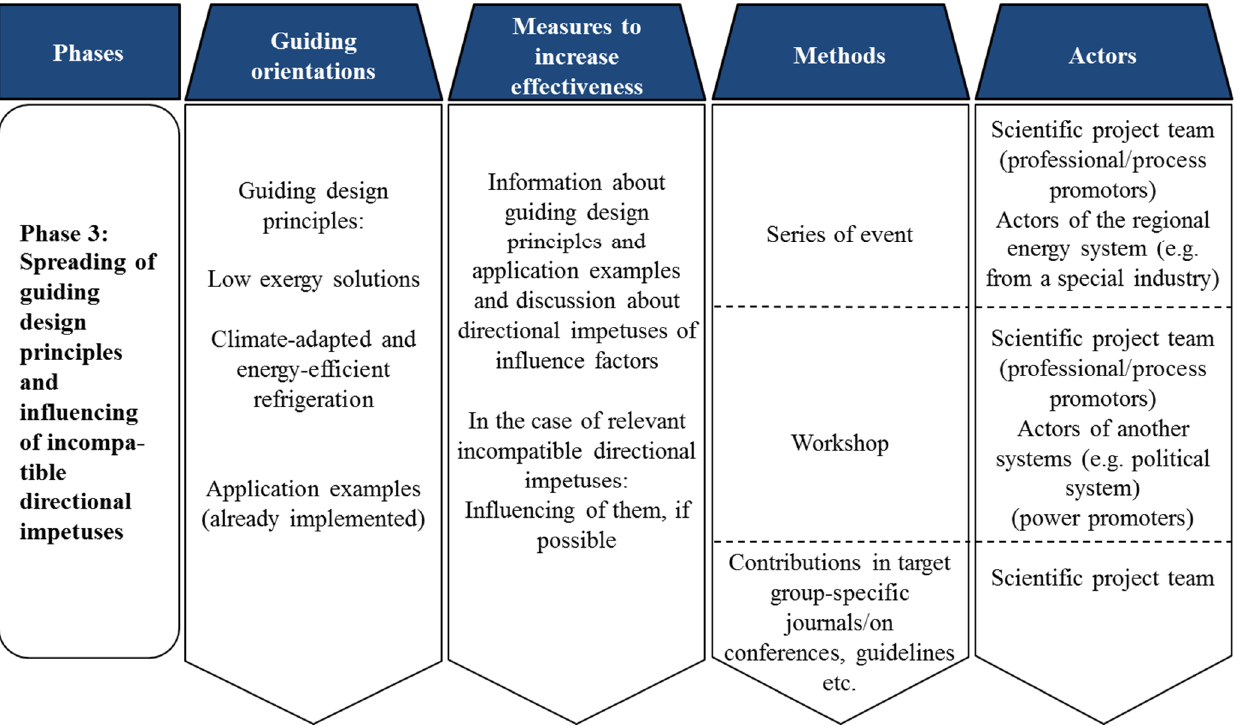
Figure 5. Phase 3 of the regional guiding orientation